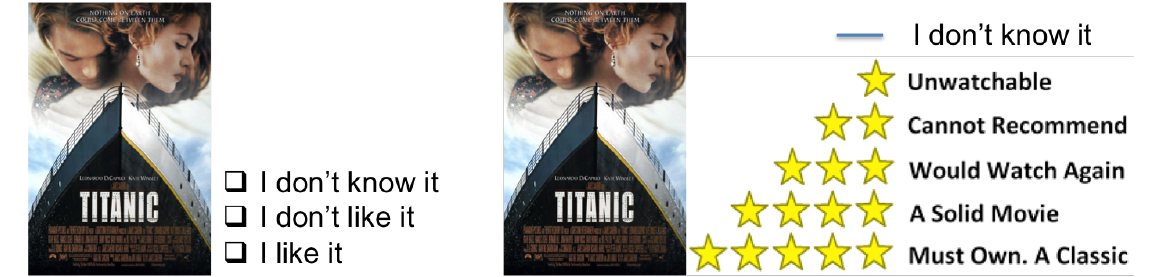
Figure 1. Example of candidate items and close-form show to